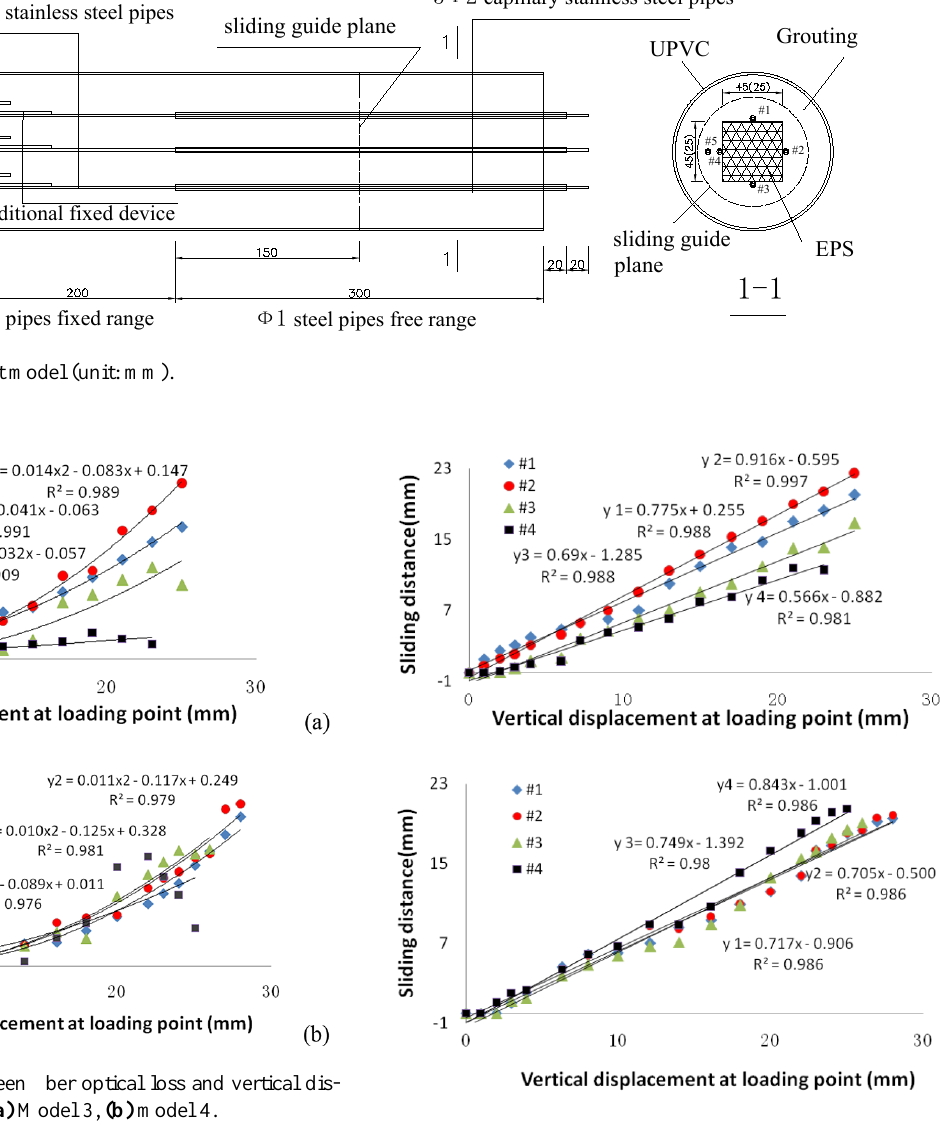
Figure 7. Relationship between fiber optical sliding distance and vertical displacement at loading point. (a) Model 3, (b) model